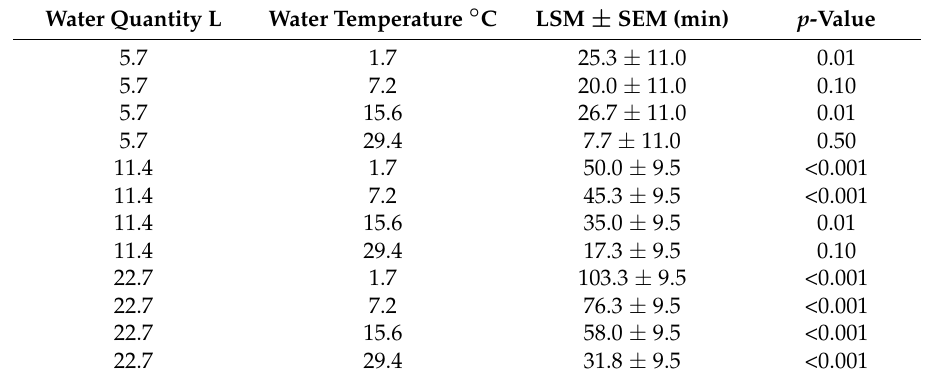
Table 5. The differences in (LSM ± SEM min) time for water quantity (5.7 L, 11.4 L, 22.7